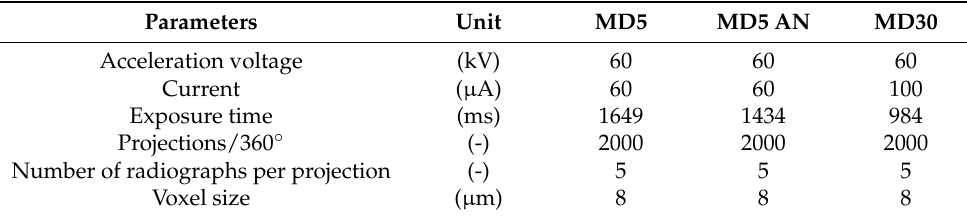
Table 2. X-ray tomography imaging parameters for samples dried inside the neutron facility. Parameters Unit MD5 MD5 AN Acceleration voltage